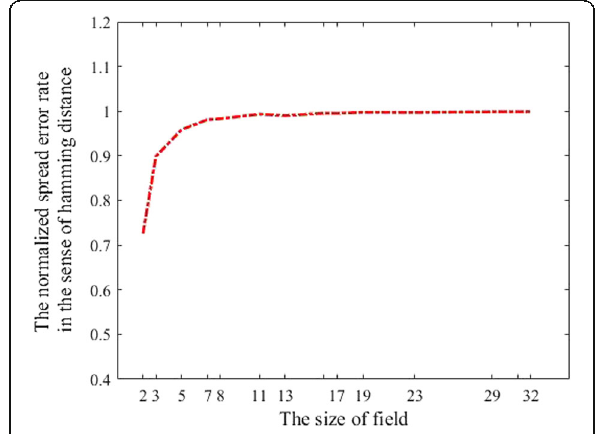
Fig. 1 The spread of errors in the sense of Hamming distance